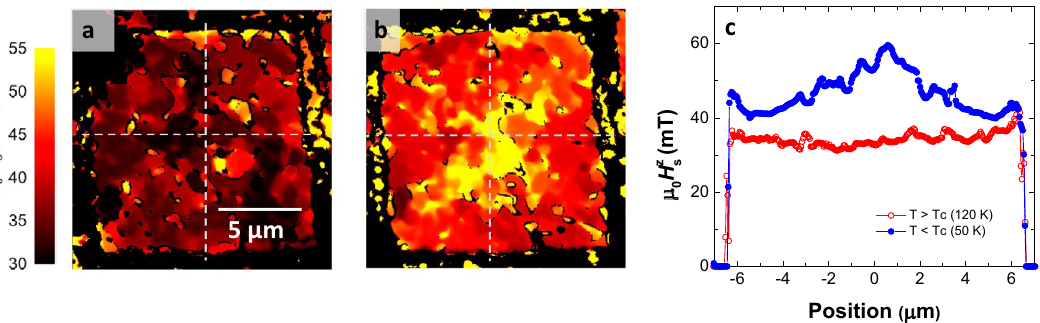
Figure 3. ( a,b ) 2D maps of the switching field above and below T C , respectively. Dashed lines indicate position along which 2 µm wide profiles have been obtained and averaged. The resulting line profile of H z s are depicted in panel c) for T > T C (red open dots) and T < T C (blue filled dots). H z s is almost constant within the normal state while it shows a clear position dependence for within the superconducting